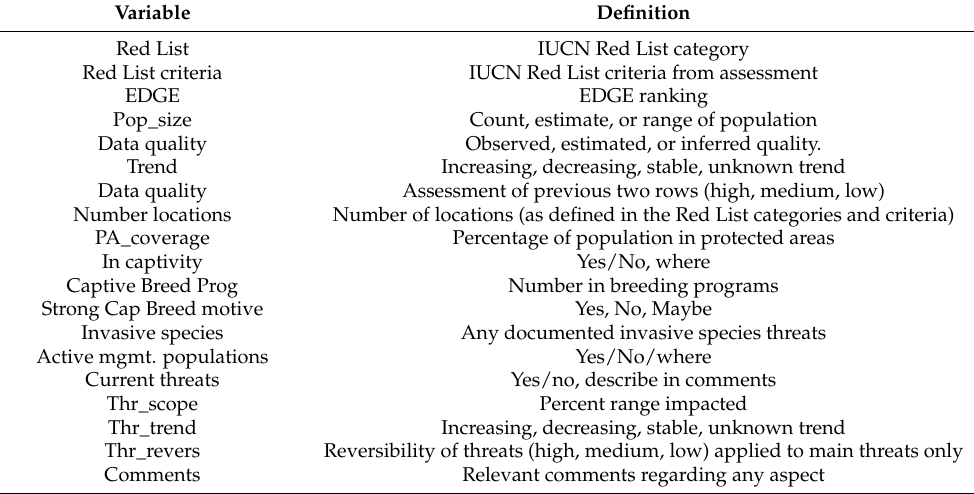
Table 2. SMSG variable list and